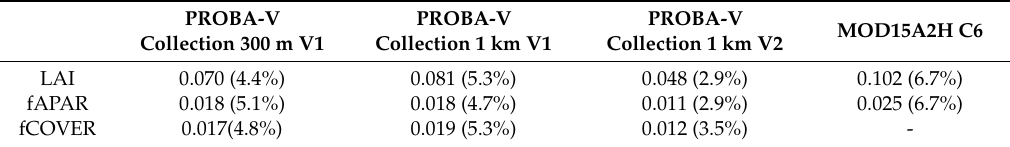
Figure 5. Boxplots of inter ‐ annual absolute differences (year 2017 versus year 2016) of the 5th and 95th percentiles of the PROBA ‐ V Collection 300 m V1 LAI ( a ), fAPAR ( b ) and fCOVER ( c ) products over LANDVAL sites. Red bars indicate median values, and the green line corresponds to the median absolute anomalies for all LAI, fCOVER and fAPAR ranges. Table 8. Inter ‐ annual median absolute difference (year 2017 versus year 2016) of PROBA ‐ V Collection 300 m V1, Collection 1 km V1 and V2 and MODIS C6 LAI, fAPAR and fCOVER products over LANDVAL sites. Relative values (%) are shown in brackets.